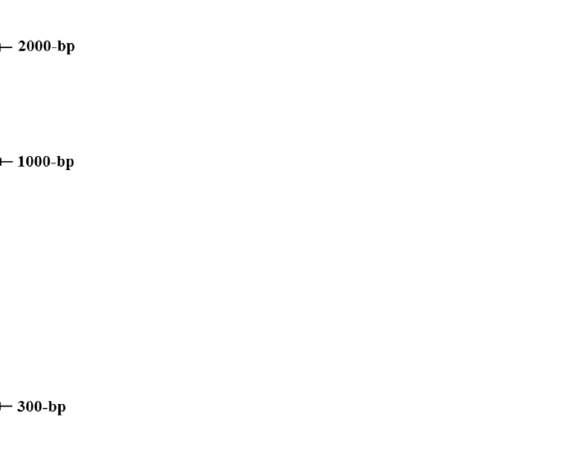
Figure 2. RAPD patterns for Meloidogyne luci (isolate PtL1) and M. ethiopica (isolate BrEt) obtained with primer OPY-11. The M. luci specific ~770 bp fragment is shown with an arrowhead. For isolate codes, see Table 1. C—Negative control; M—DNA marker (HyperLadder II, Bioline).